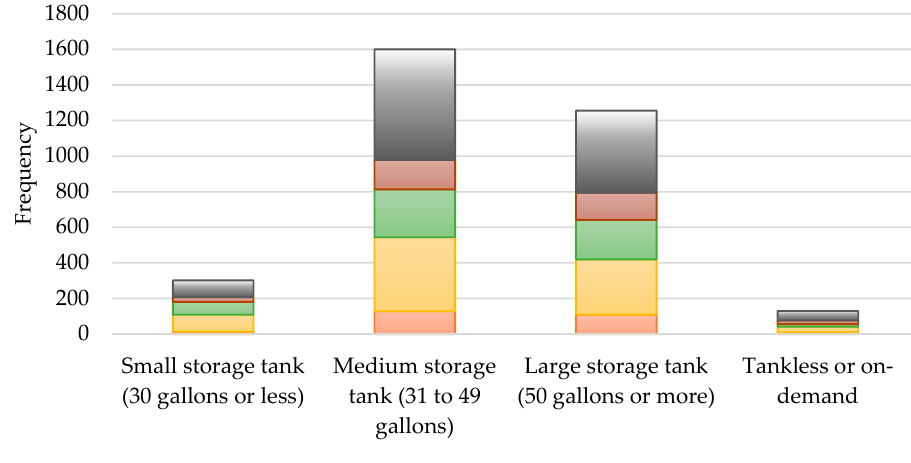
Figure 10. Type of water heating equipment per climate zone (total n = 3288).